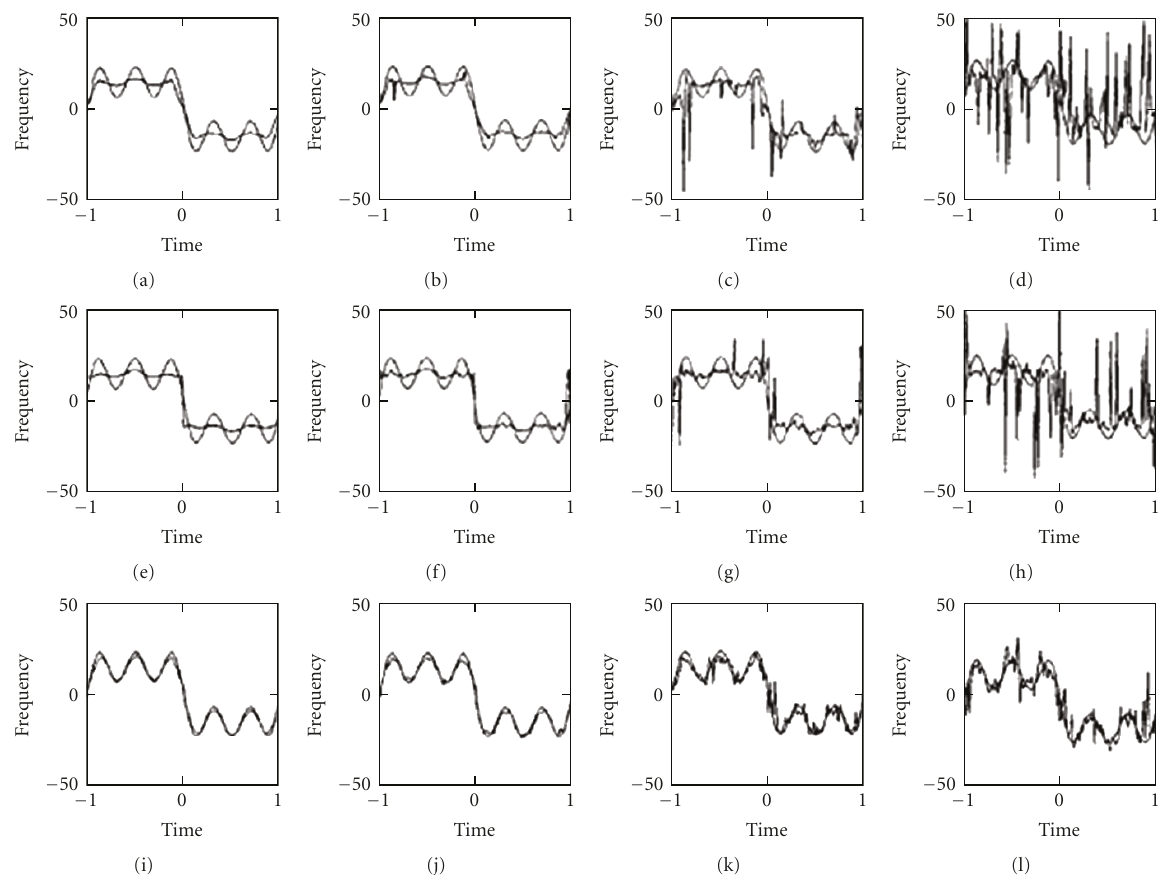
Figure 19: (a)–(d) IF estimation based on WD, (e)–(h) spectrogram, (i)–(l) complex lag-distribution. First column: SNR = 30 dB. Second column: SNR = 10dB. Third column: SNR = 3 dB. Fourth column: SNR = 0dB (all adopted from Stankovic [165]).